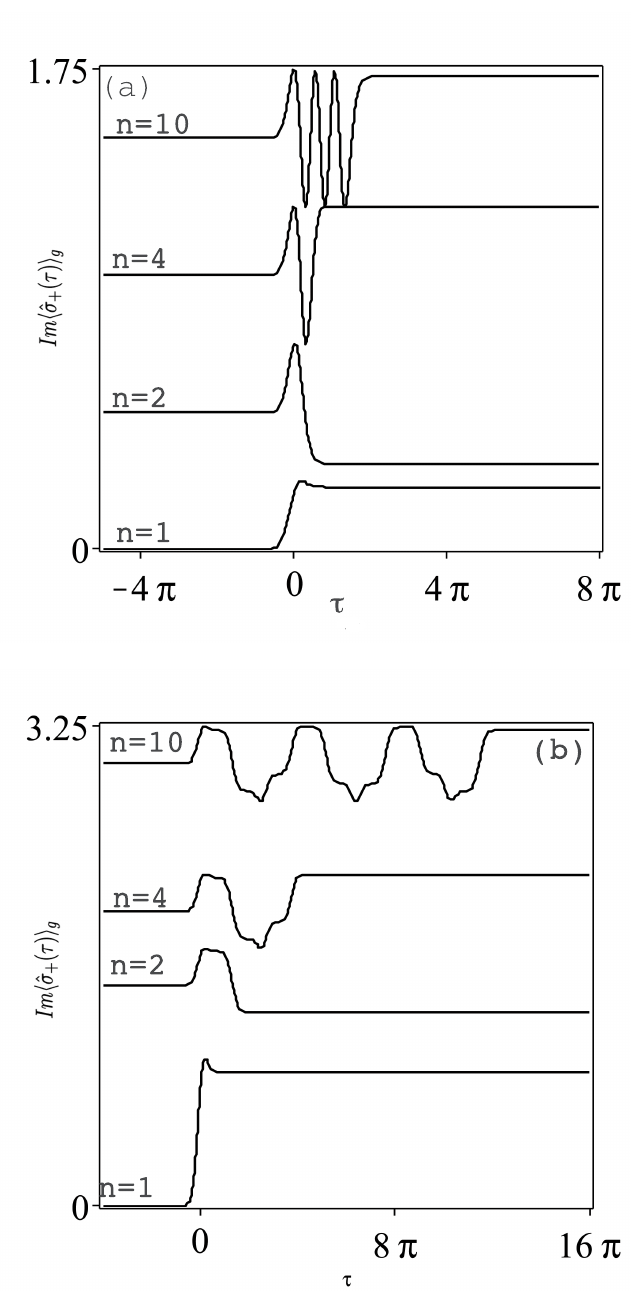
Figure 2. ( a ) Plot of Im (cid:104) ˆ σ + ( τ ) (cid:105) g against τ , with Ω 1 = 1, τ R = 0.5 for different pulse numbers. ( b ) As ( a ), but for τ R = 4